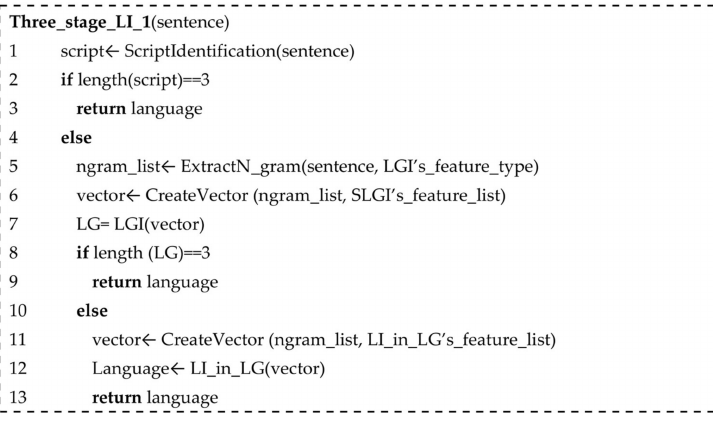
Figure 3. Pseudocode of three-stage